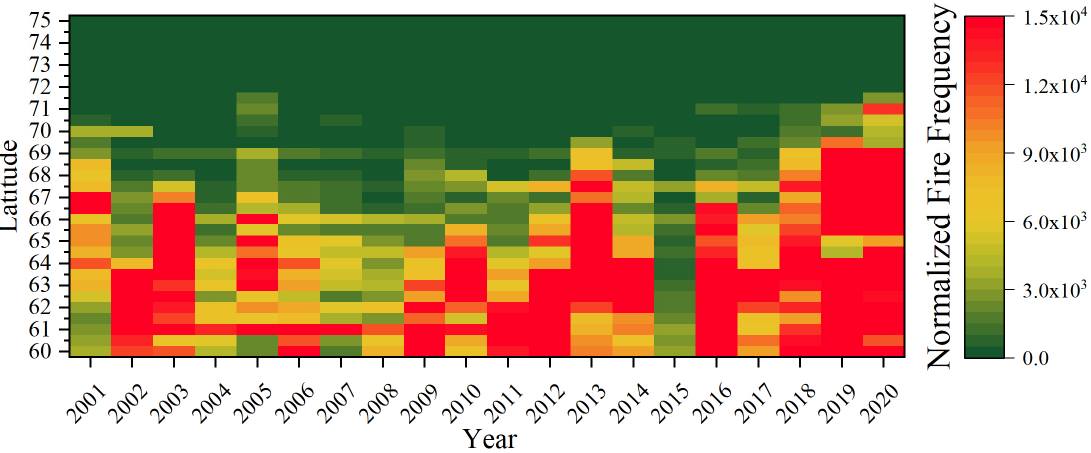
Figure 2. Spatial distribution of active fire pixels. Latitude vs. time (with number of fire pixels normalized to account for reduced area with increasing latitude).